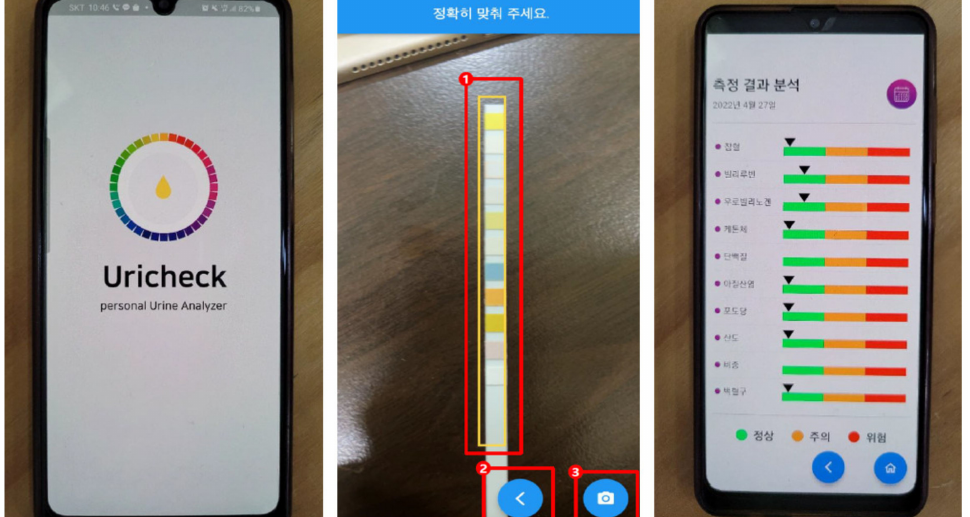
Figure 5. Urine dipstick test application. 1. Region of interest 2. Button for backward movement. 3. Button for taking a picture.